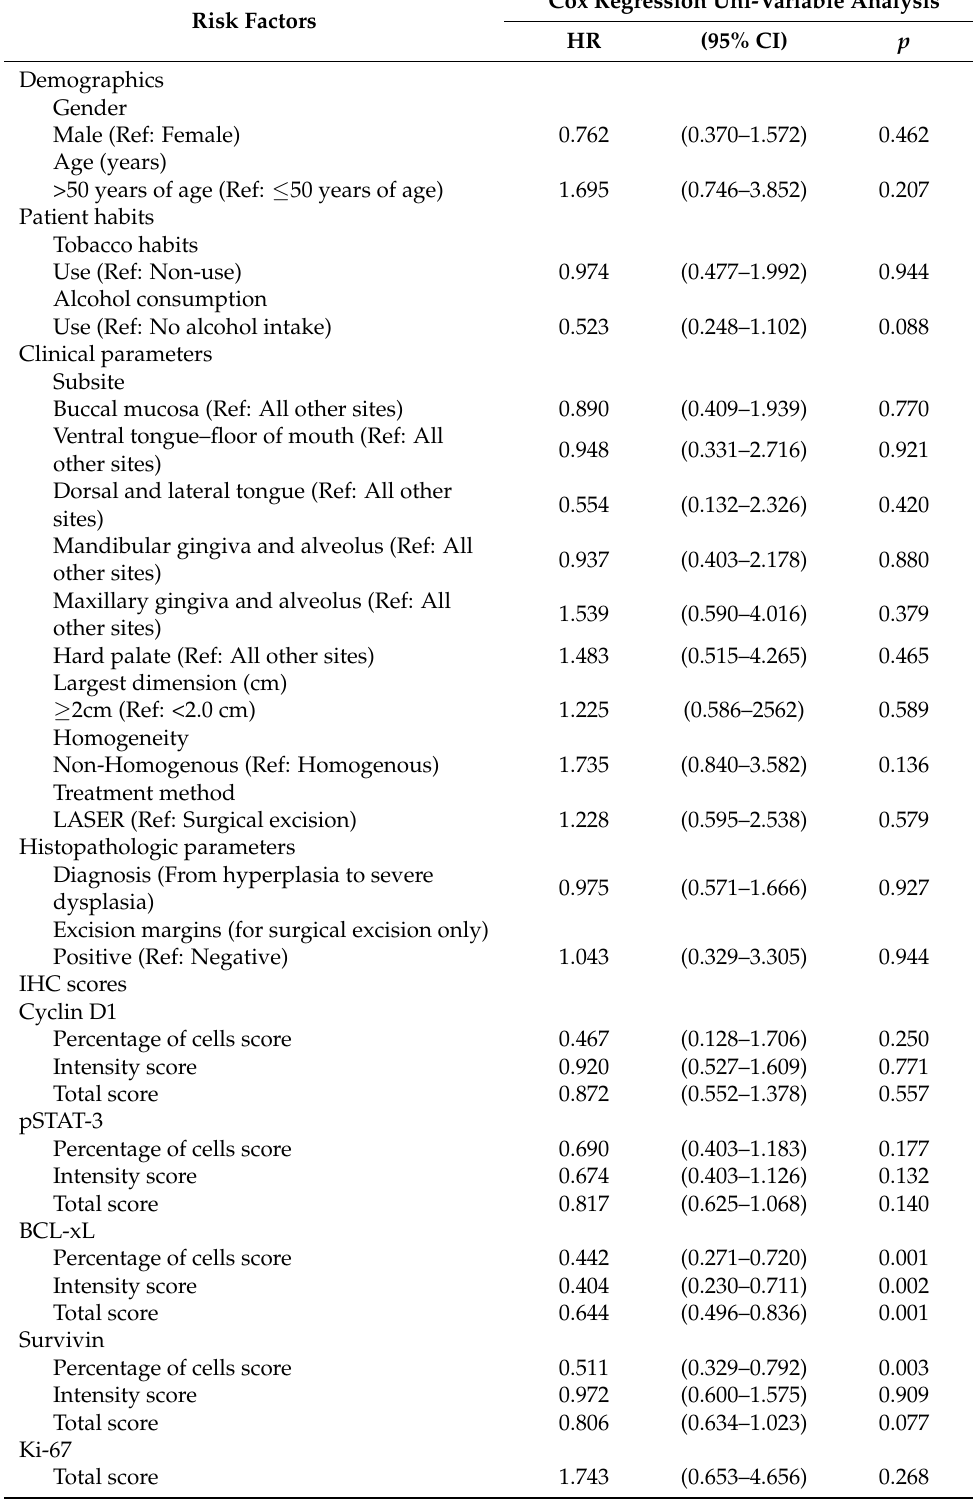
Table 5. Uni-variable Cox regression analysis of risk factors for the recurrence of primary oral leukoplakia (PLs)